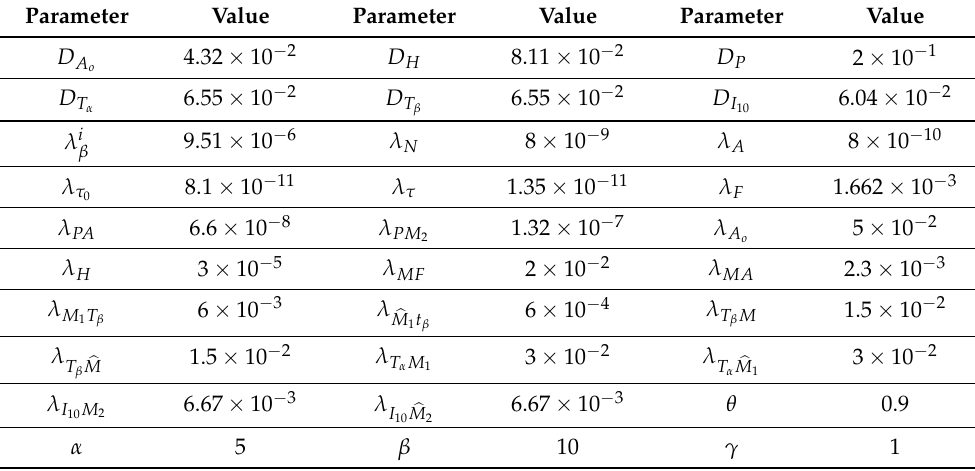
Table 2. Parameter